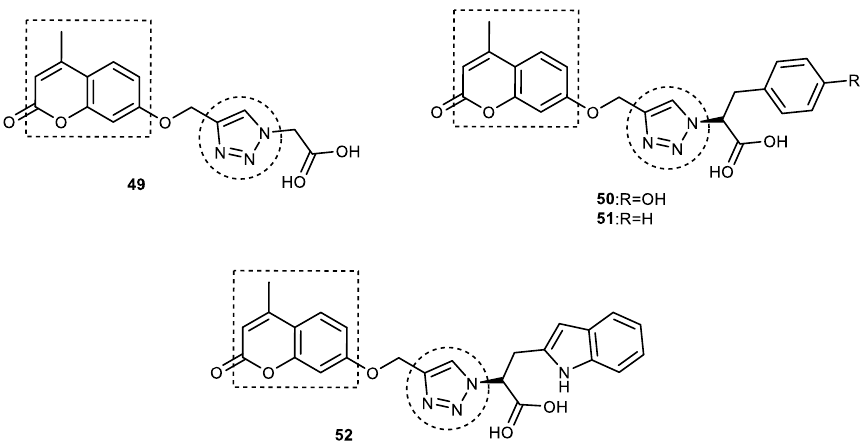
Figure 17. Chemical structure of coumarin – 1,2,3-triazole – amino acid